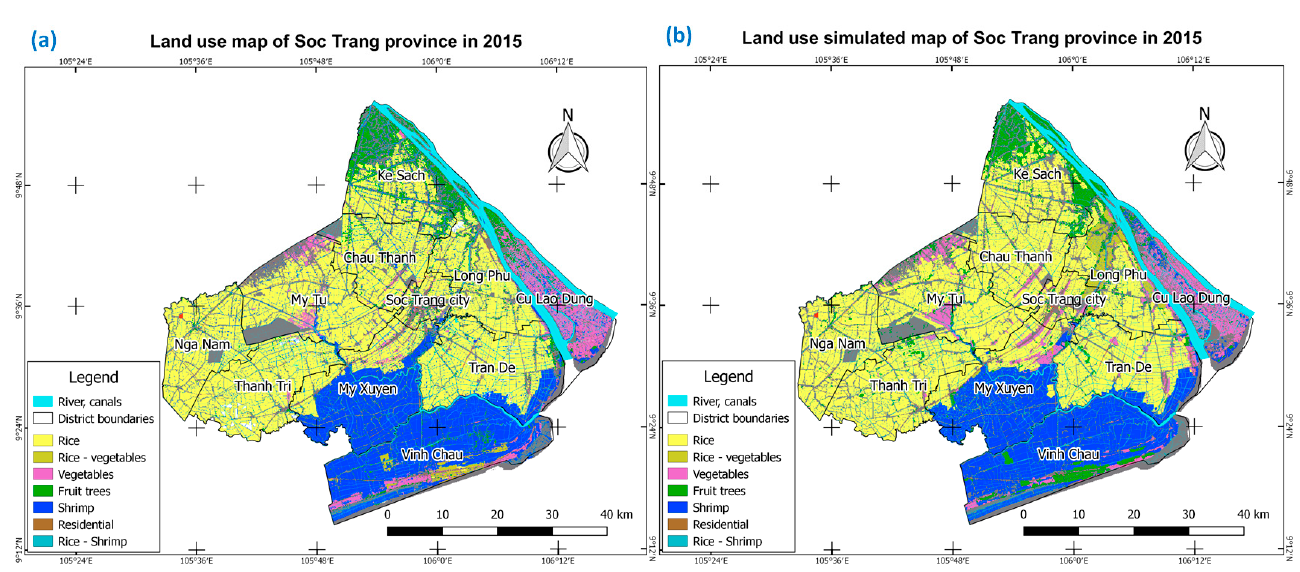
Table 2. Comparison of land use simulated with the observed data in 2015 and 2020.